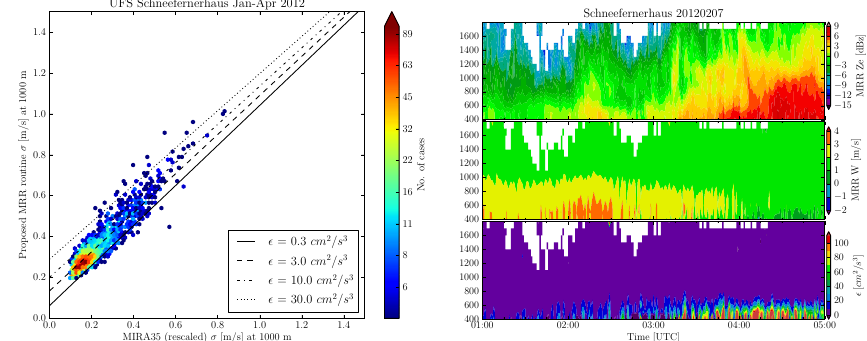
Fig. 10. Left: scatterplot comparing spectral width ( σ ) of MRR and MIRA35. The lines indicate the expected offset due to the different beam widths caused by a dissipation rate of (cid:15) = 0 . 3 (solid), 3.0 (dashed), 10.0 (dash-dotted) and 30.0cm 2 s − 3 (dotted). Right: time-height plot showing Z e (top) and W (centre) measured by MRR using the proposed method. The bottom panel features the dissipation rate ( (cid:15) ) derived from comparison of σ of MRR and